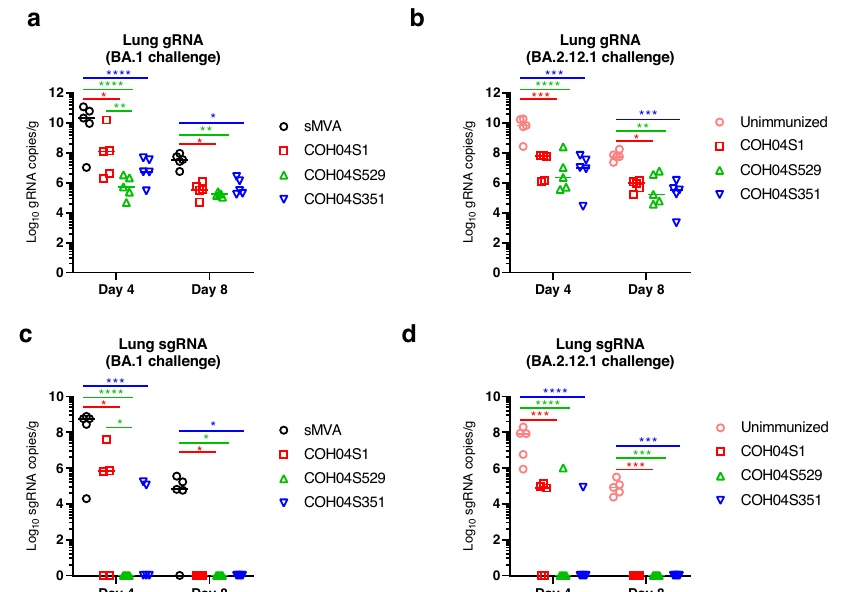
Fig. 3 COH04S1 and Omicron BA.1- and Beta-modi fi ed vaccines protect hamsters from lower respiratory tract infection following virus challenge with Omicron BA.1 or BA.2.12.1. SARS-CoV-2 genomic RNA (gRNA, a , b ) and sub-genomic RNA (sgRNA, c , d ) copies were quanti fi ed by qPCR in lung tissue of COH04S1, COH04S351, and COH04S529 vaccine and control groups at days 4 and 8 following challenge with Omicron subvariants BA.1 ( a , c ) and BA.2.12.1 ( b , d ). Lines indicate median RNA copies. Two-way ANOVA followed by Tukey ’ s multiple comparison test was used following log transformation. *0.05 < p < 0.01, **0.01 < p < 0.001, ***0.001 < p < 0.0001, **** p < 0.0001. When not indicated, differences are not signi fi cant ( p > 0.05).